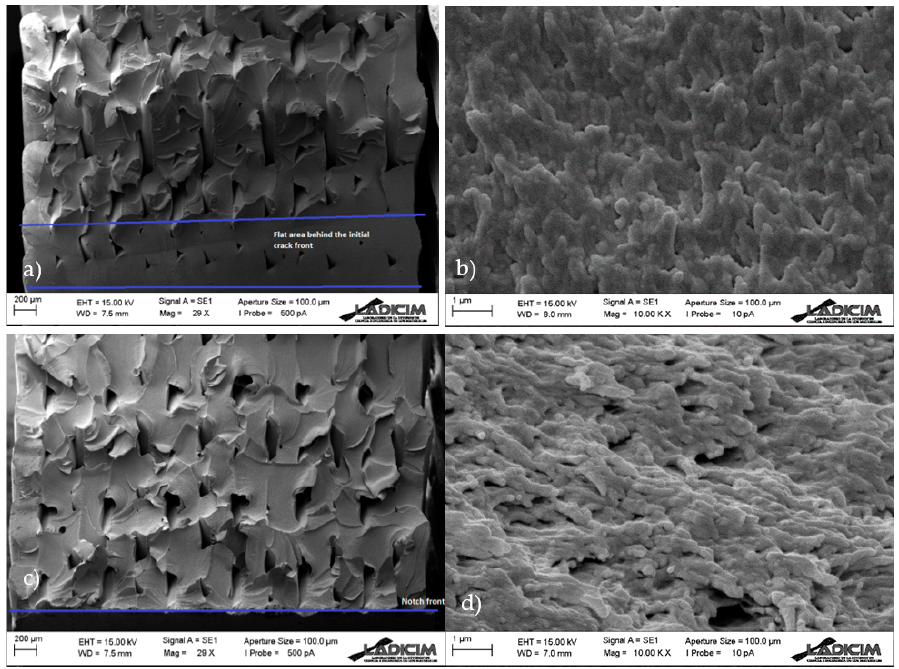
Figure 9. SEM images obtained from 45 / − 45 samples; ( a ) overall view of cracked specimen; ( b ) detail of fracture micromechanisms at the crack front; ( c ) overall view of specimen with a notch radius of 2 mm; ( d ) detail of fracture micromechanisms at the defect front.